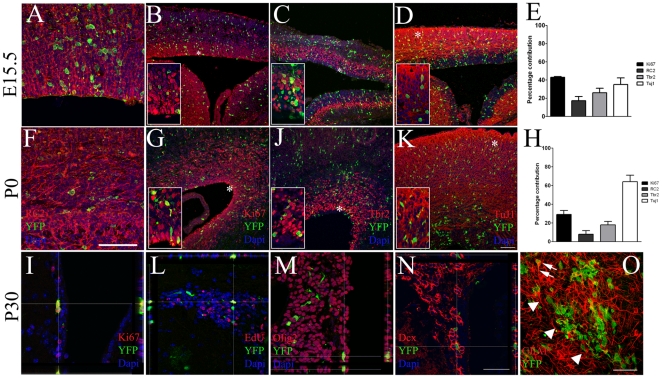
Embryonic AspM precursors generate cortical neurons and proliferating cells of embryonic and post natal germinal niches.AspM-CreERT2/Rosa26YFP mice were administered with Tam at E12.7 and E13.2 and then brains were collected at E15.5 (n = 4, A–E), P0 (n = 4, F–H) and P30 (n = 4, I–O). Confocal optic sectioning of brain coronal slices were probed for YFP and: RC2 (A, F), ki67 (B, G), Tbr2 (C, J) and TuJ1 (D, K). YFP+ cells expressing each marker were found within the cortical wall. Histograms in E and H show the mean percentages (± S.D.) of double positive cells counted at each time point from 4 independent experiments. High magnification images are provided in insets, asterisks indicate their position on low magnification pictures. P30 mice received two daily injections of EdU for 5 consecutive days before the sacrifice. SVZs were labeled for YFP and: ki67 (I), EdU (L), Olig2 (M) and Dcx (N). Whole mount of the lateral ventricle stained for YFP and GFAP is provided in panel O. Arrows indicate double positive cells and arrowheads a cluster of YFP+ cells. Scale bars 100 µm.